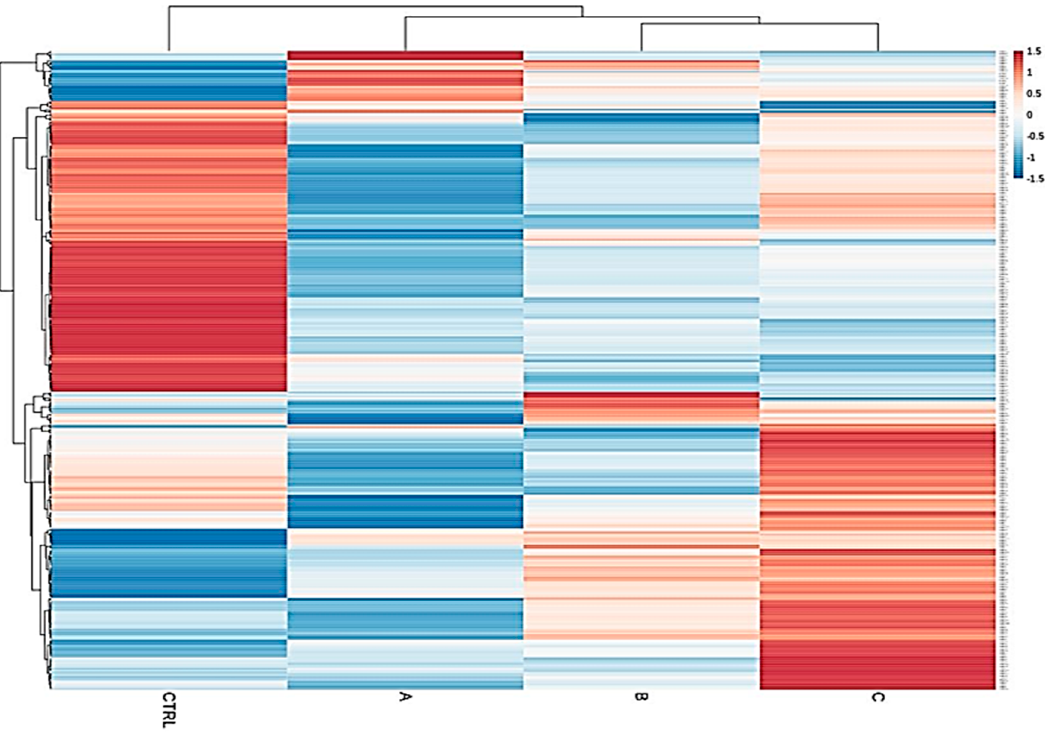
Figure 1. Heatmap of total samples based on the Child–Pugh score (A, B and C). A clear separation of upregulated and downregulated microRNA (miRNA) profiles of the control group from the diseased cohorts emerged, confirming that miRNA expression patterns between these classes and the normal group are strongly different.